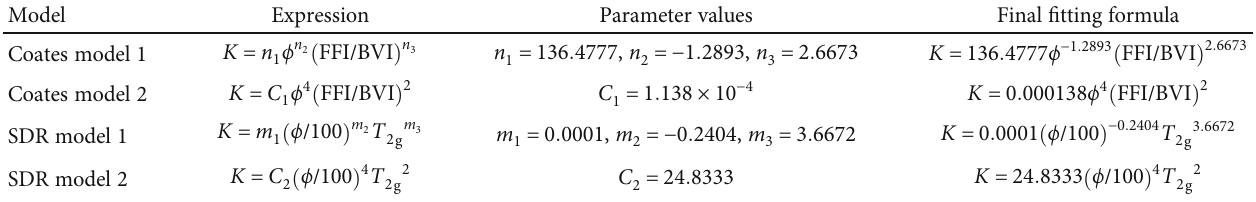
Table 4: Results of undetermined parameters of four models.